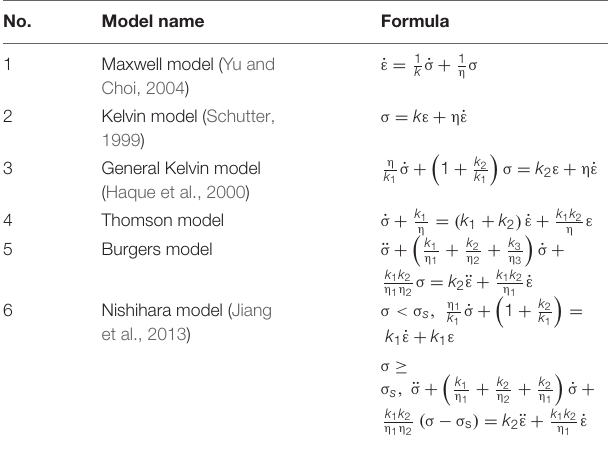
TABLE 4 | Widely used creep models available in